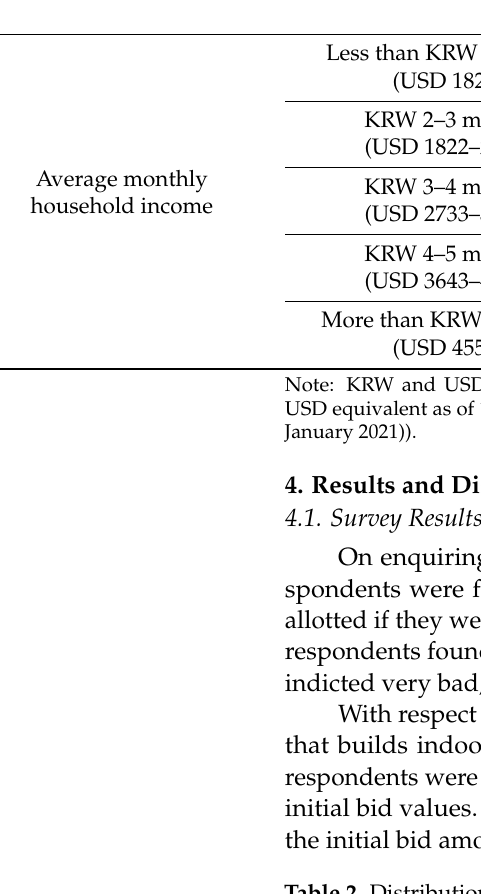
Table 2. Distribution of responses based on bid